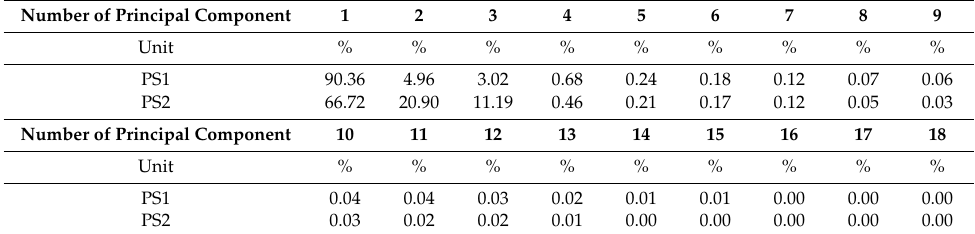
Table 3. Variance contribution of partial principal components.